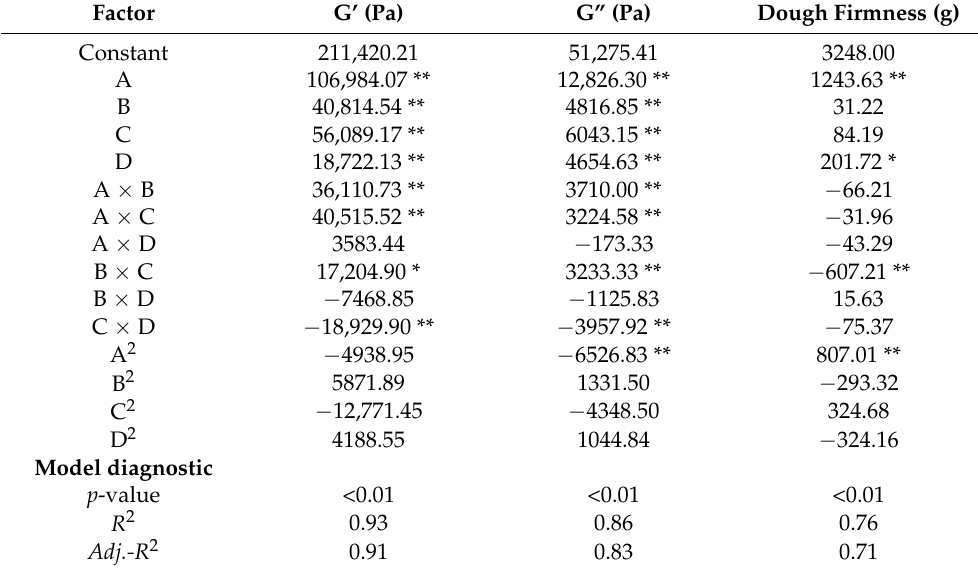
Table 2. ANOVA results for quadratic model fitted to pasta dough